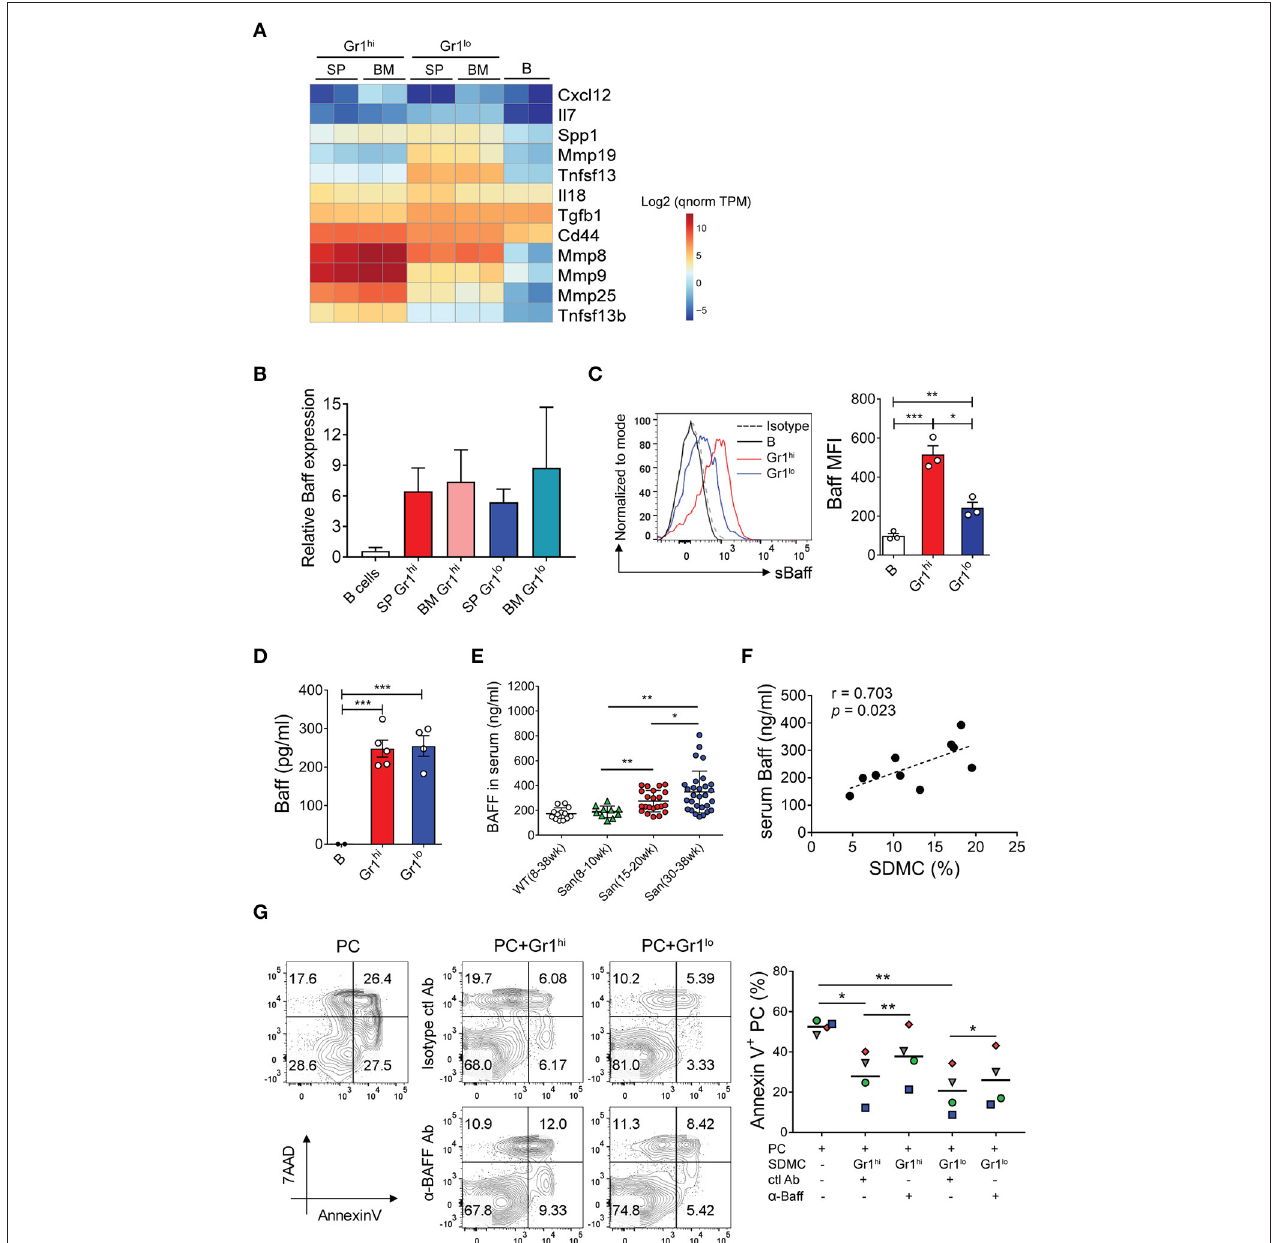
FIGURE 6 | BAFF-mediated effects of SDMCs on PC survival. (A) Spleen- and BM-derived CD11b + Gr-1 hi and CD11b + Gr-1 lo cells from sanroque mice and WT CD19 + B cells were assayed by RNA-seq. Differentially-expressed genes which encode known PC survival factors are displayed as a heatmap. The quantile-normalized (qnorm) TPM values were scaled in the logarithm with base 2 and are presented based on the color-code in the legend. (B) These cells were assayed by quantitative RT-PCR. (C) The SDMC subsets were analyzed by FACS to detect surface BAFF. Representative FACS profiles and mean fluorescence intensities (MFI) are displayed as means ± SDs with symbols representing values of individual mice. (D) The SDMC subsets were cultured in the presence of 1 µ g/ml LPS for 48h and supernatants were assayed by ELISA to detect soluble BAFF. (E) Sera were collected from WT and sanroque mice at the indicated ages and analyzed by ELISA. (F) Serum levels of BAFF and percentages of SDMCs in sanroque mice were analyzed by correlation analysis. (G) CD11b + Gr-1 hi and Gr-1 lo subsets of SDMCs were separately sorted and co-cultured with PCs in the presence of anti-BAFF or isotype-matched control mAb, and assayed by FACS after 48h. FACS profiles gated on PCs and plots indicating the values of individual samples with means (horizontal lines) are shown. The data are representative of 2 (B) or 4 (C–G) independent experiments. Each symbol represents an individual experiment. * p < 0.05, ** p < 0.01, and *** p < 0.001 by paired (G) and unpaired (C–E) Student’s t